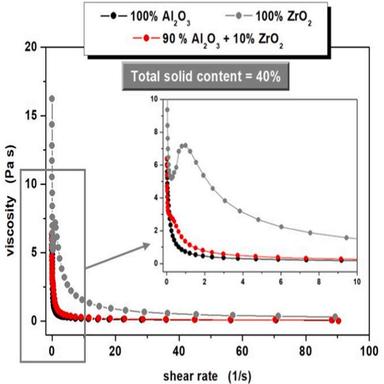
Viscosity curves of casting slips containing 40 vol.%of solid phase.